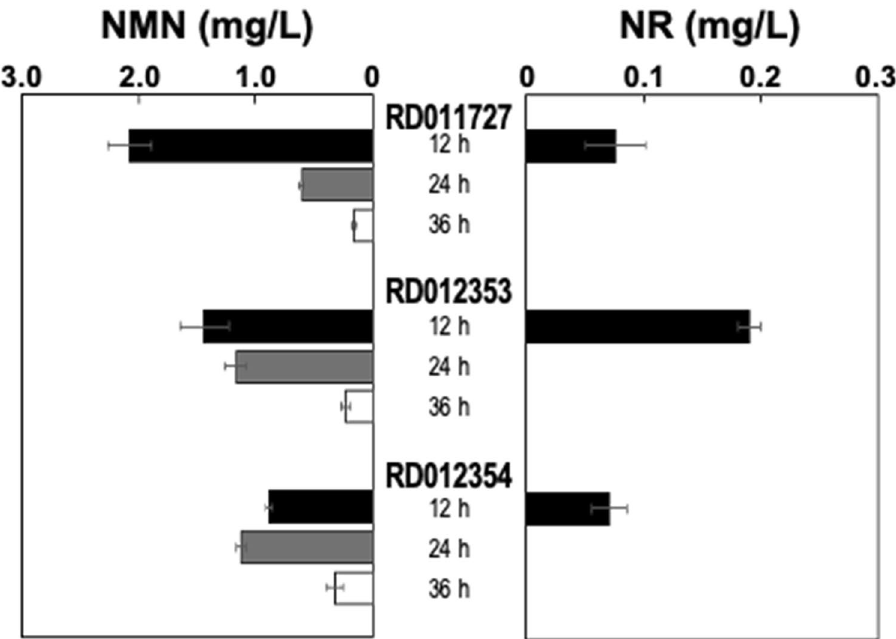
Figure 4. Intracellular accumulation of NMN and NR in the candidate LAB. Each candidate LAB was cultivated in MRS medium containing 1% d-fructose and the amounts of NMN and NR in the cell extract were measured by the fluorescent HPLC analysis. Black, gray, and white bars represent 12-, 24-, and 36-h cultivation, respectively. Error bars show standard deviations from biological